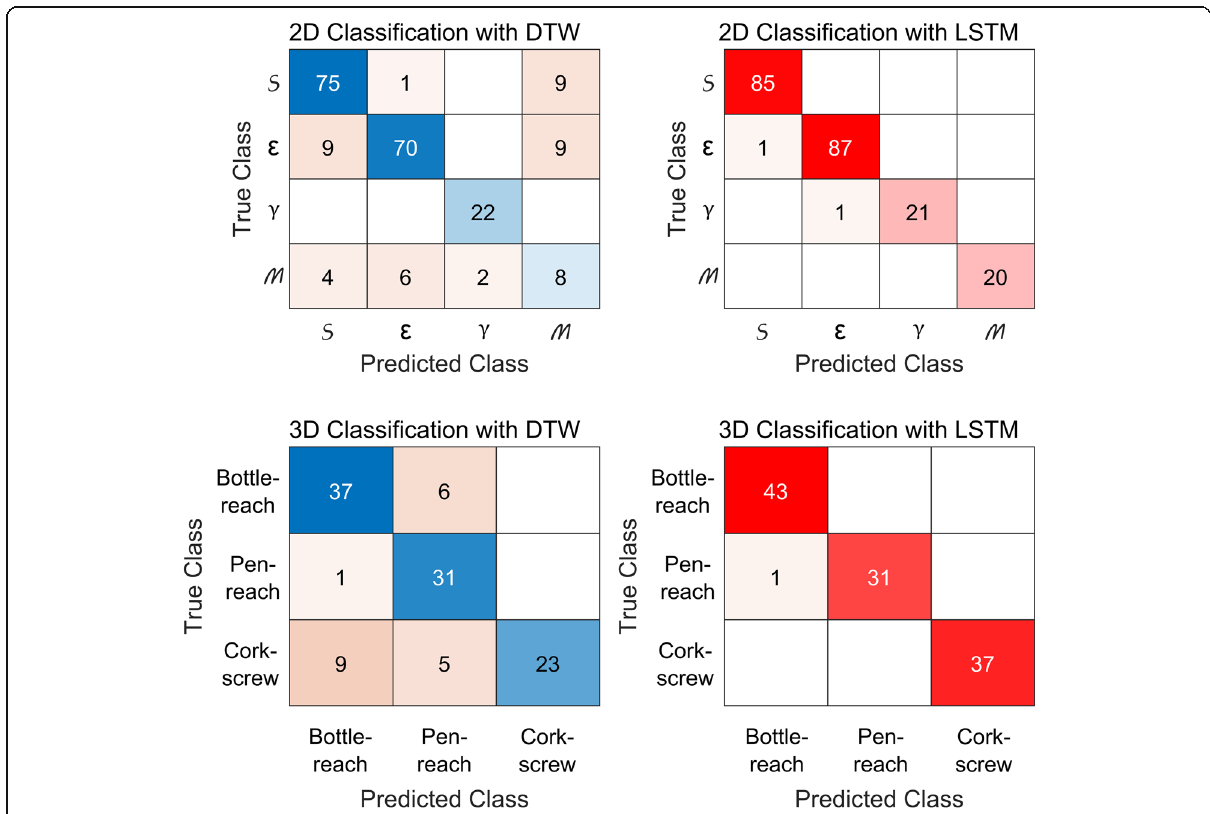
Fig. 3 Confusion matrices illustrating DTW and LSTM-based classifier performance for 2D & 3D